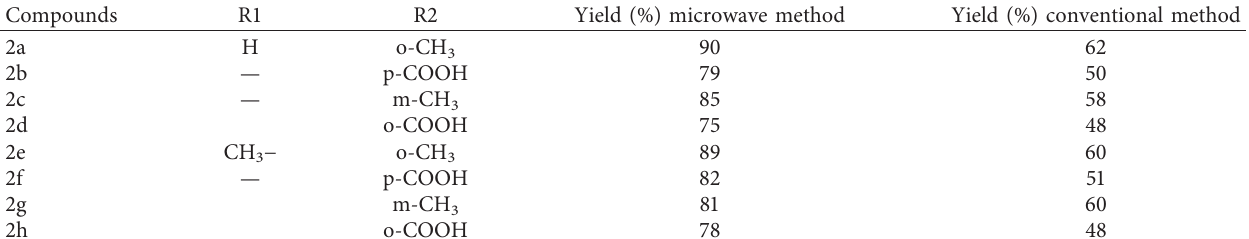
Table 2: Synthesized compounds (2a–h).